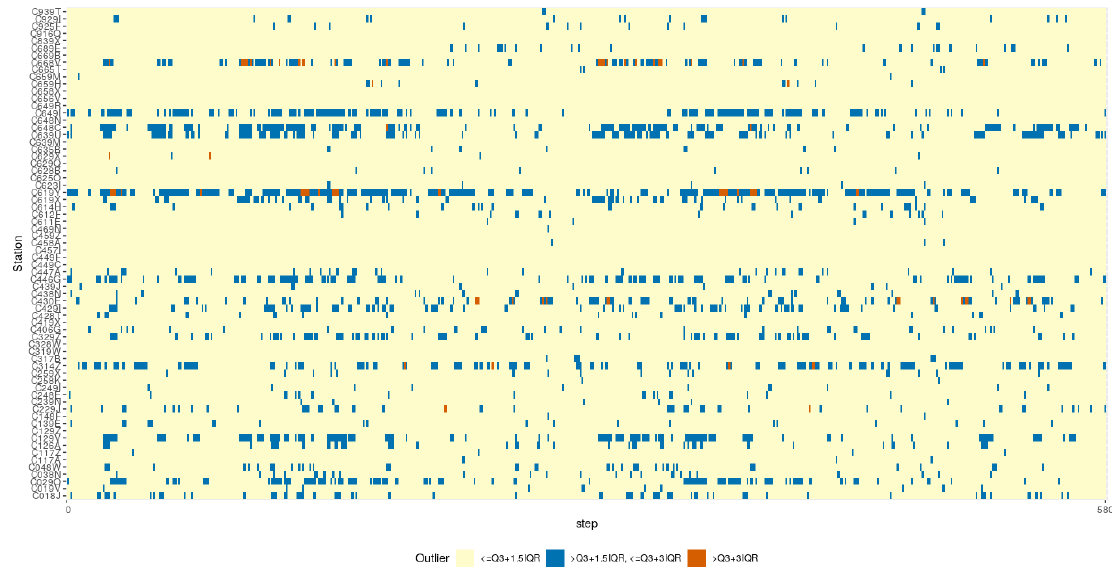
Figure 9. Outliers analysis ( VMAX 10 m > 16.3 m/s).